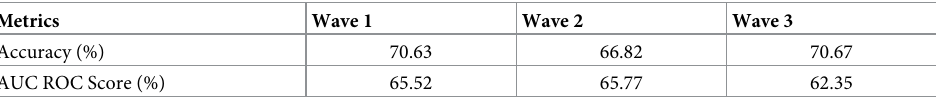
Table 4. XGBoost performance metrics for each wave.